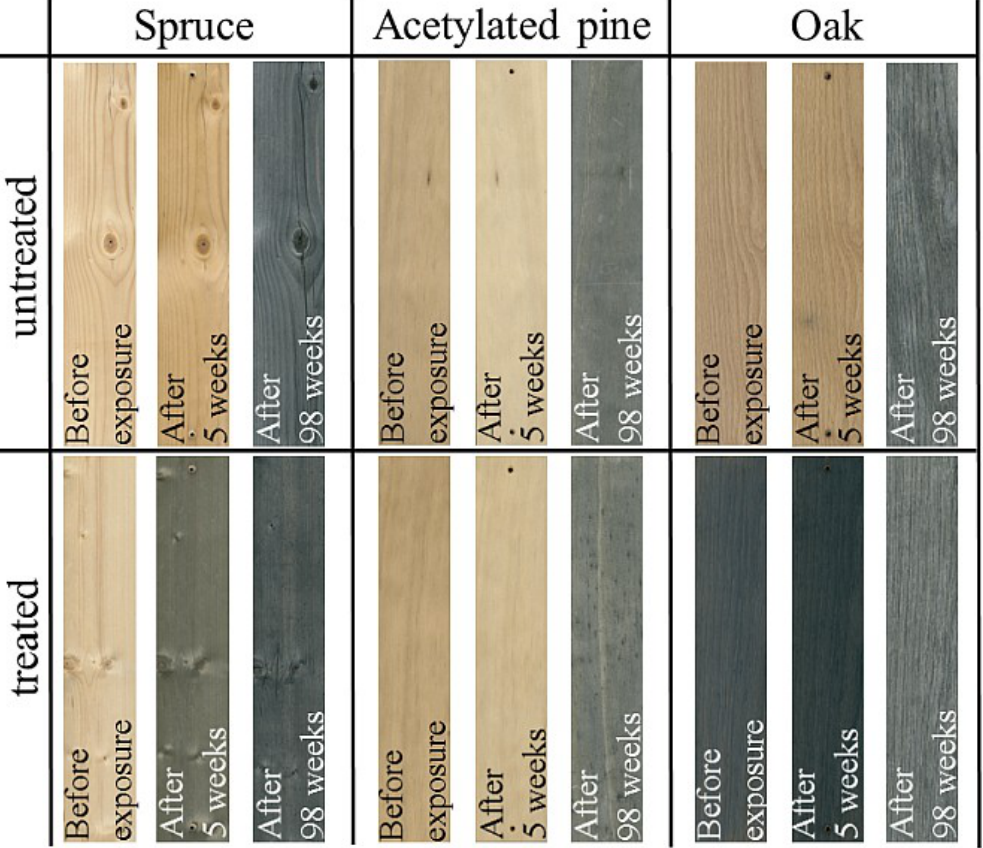
Figure 6. Untreated and iron (II) sulfate-treated specimens of spruce, acetylated radiata pine, and oak of sample set 3 before and after 5 and 98 weeks of exposure at 45° to the south.